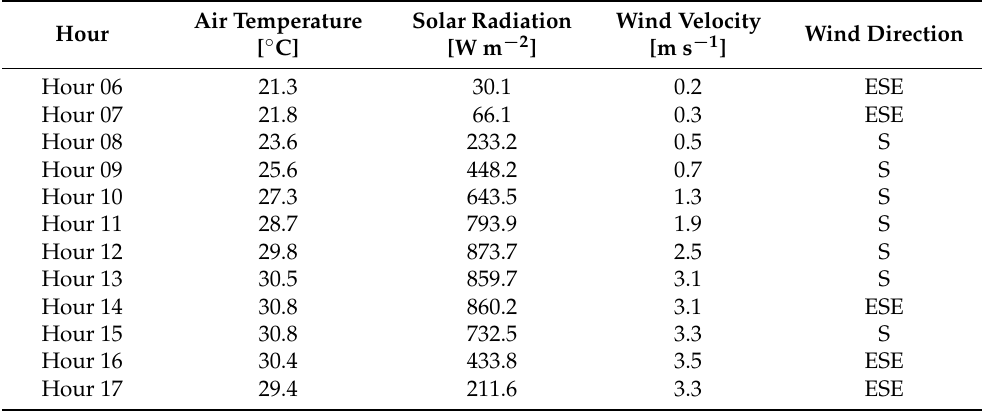
Table 2. Mean hourly weather conditions used as input parameters to the CFD